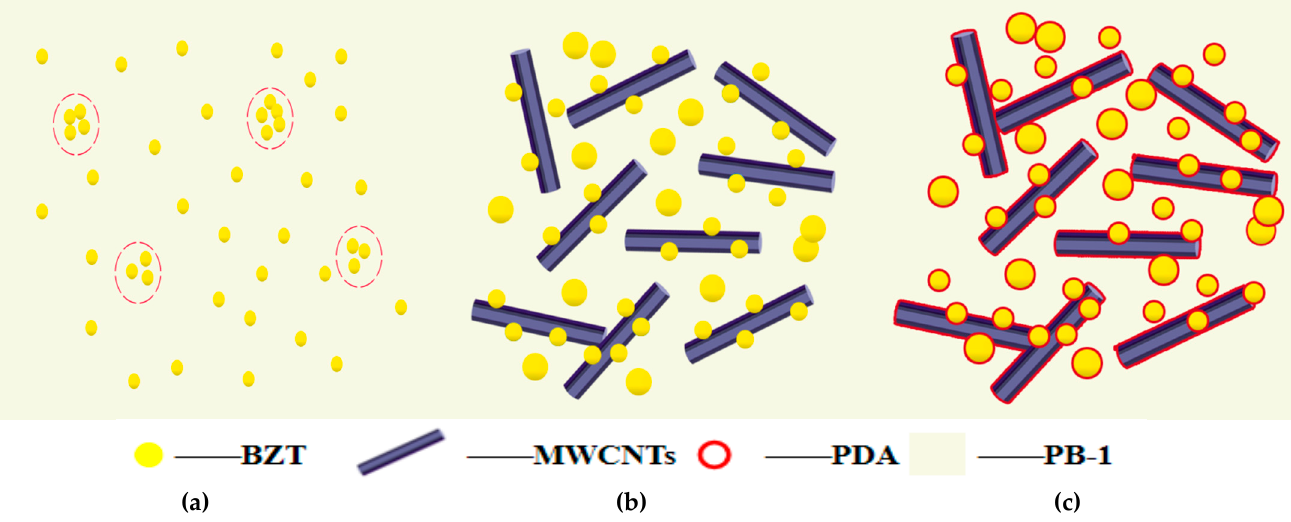
Figure 9. Schematic of the dispersion of fillers in the PB-1 matrix. In this schematic, ( a ), ( b ), and ( c ) are composite films formed by adding BZT, BZT@MWCNTs, or PDA-modified BZT@MWCNTs, respectively.